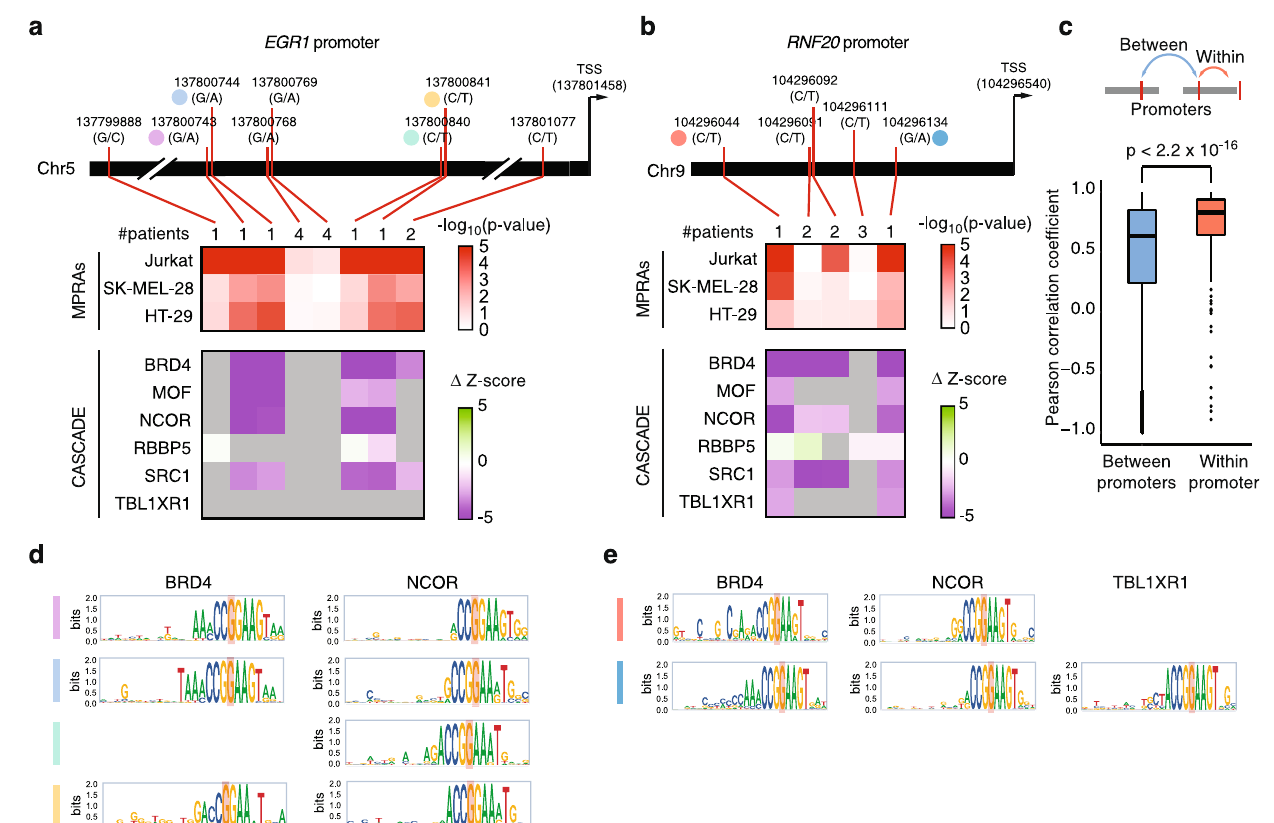
Fig.5|AlteredtranscriptionalactivityandCOFrecruitmentwithinpromoters. a , b ChangesinMPRAactivityandCOFrecruitmentforTF-ABTNCVinthe( a ) EGR1 and( b ) RNF20 promoters.Thetopheatmapsshowthelog 10 ( p -value)ofexpression allelicskewinMPRAinJurkat,SK-MEL-28,andHT-29cells. P valueswerecalculated using two-sided Student ’ s t-test. The bottom heatmaps show the altered COF recruitment by CASCADE, which is indicated as Δ z-score. Gray cells indicate cases where the COF was not recruited to either NCV allele. Numbers at the top of the heatmaps indicate the number of patients in PCAWG carrying the indicated NCV. Mutation and TSS coordinates are indicated. c Pearson correlation coef fi cient